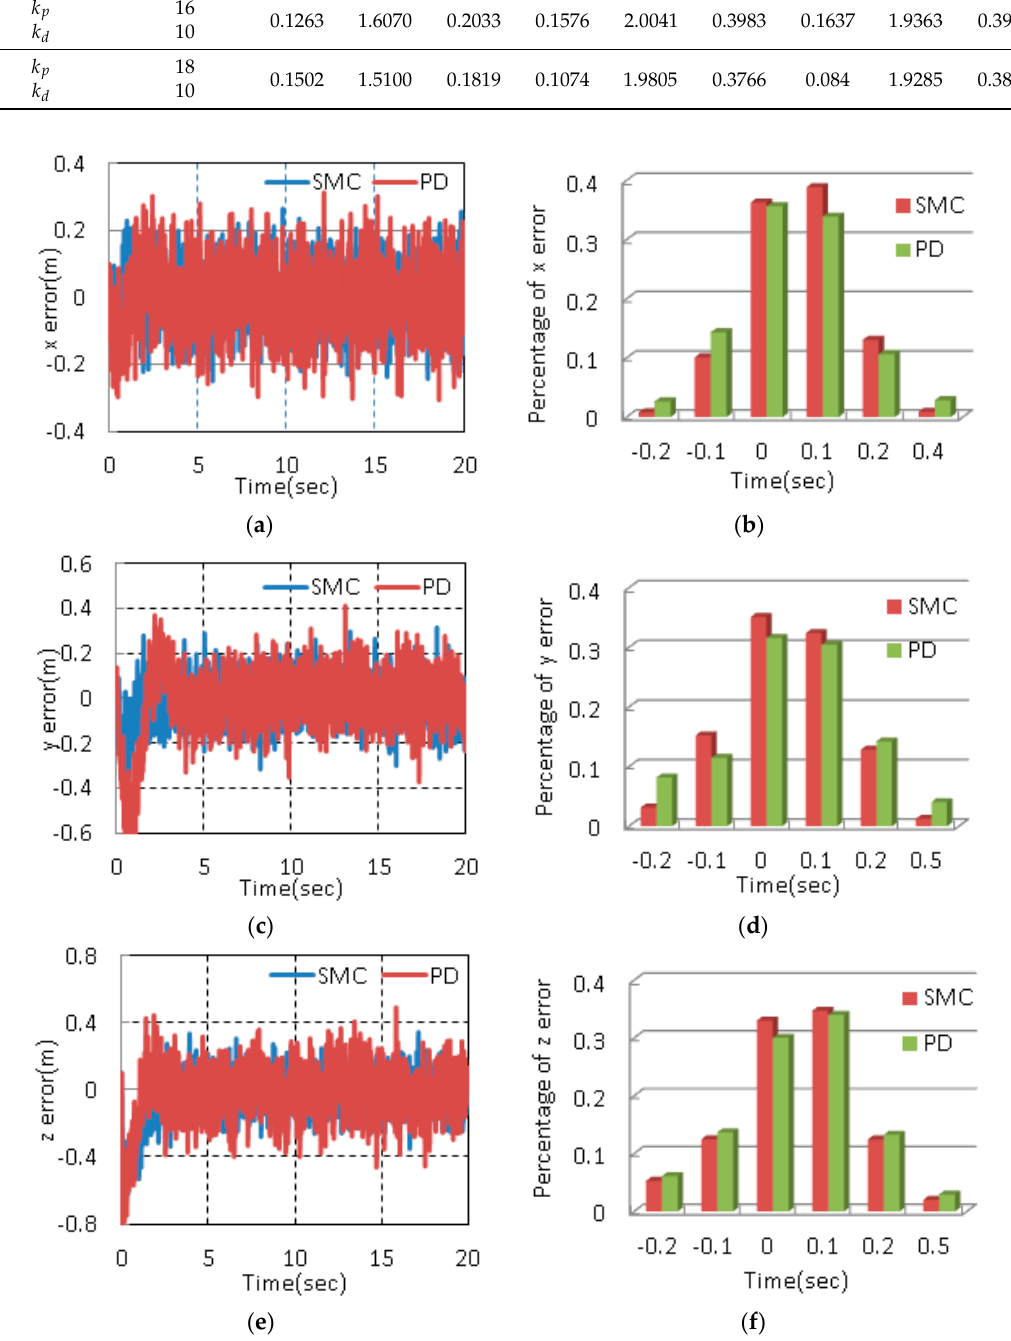
Figure 13. Position errors and histograms of position errors in Case 1 ( a ) x position error; ( b ) Percentage of x position error; ( c ) y position error; ( d ) Percentage of y position error; ( e ) z position error; ( f ) Percentage of z position error.